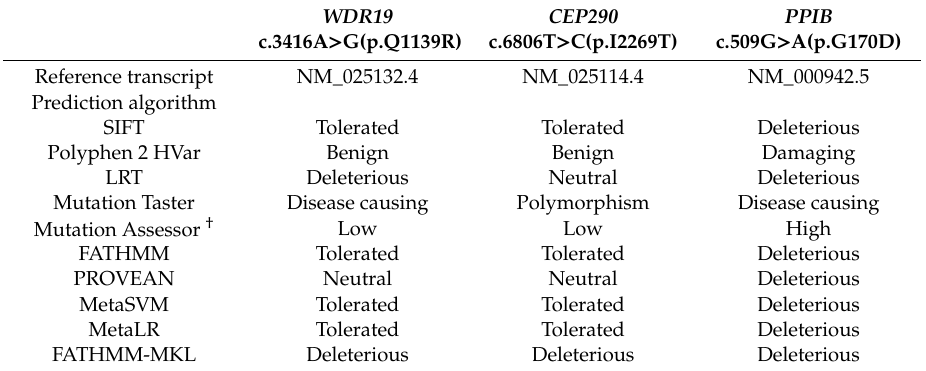
Table 2. In silico predictions of functional e ff ects for the three genetic variations detected in this